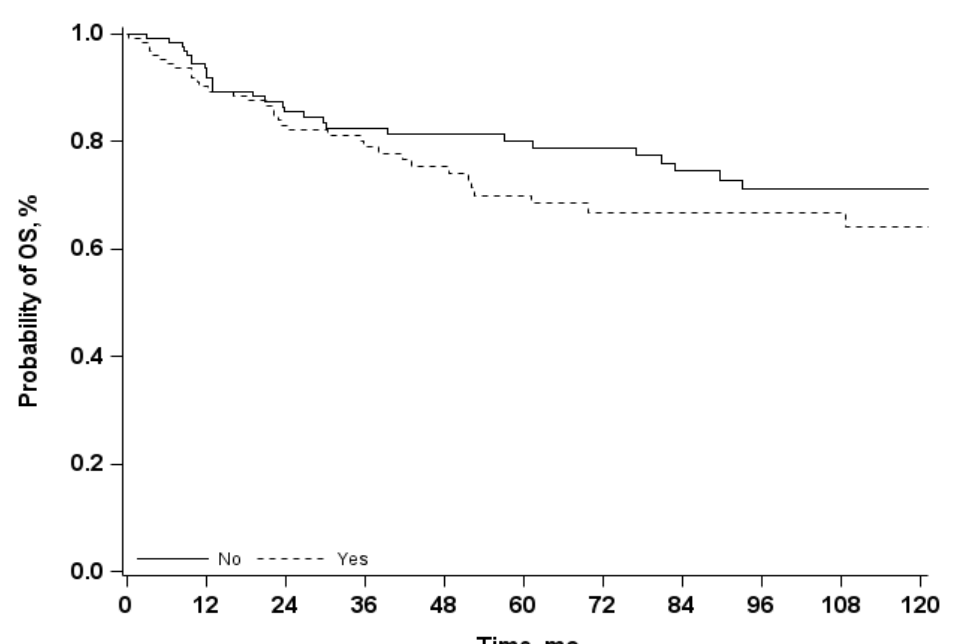
Figure 2. Overall Survival (OS) Kaplan-Meier curves in patients with and without relapse; mo = months.